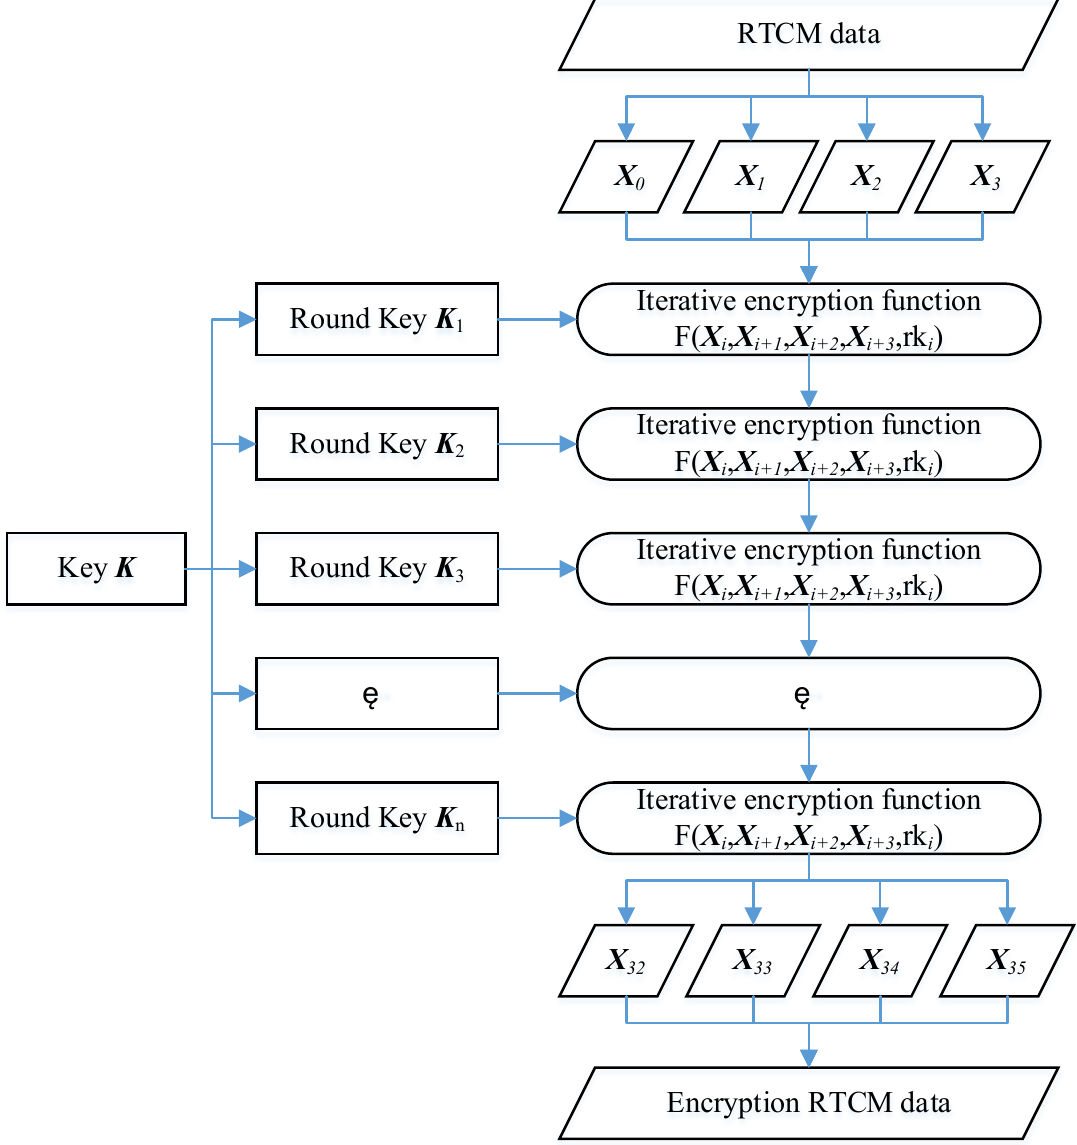
Figure 3. Iterative encryption of RTCM data.